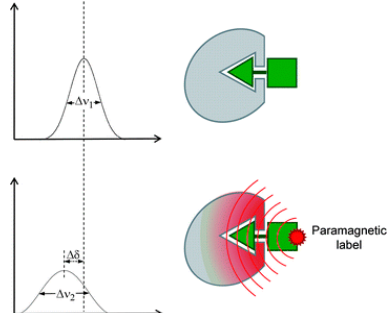
Figure 10. Paramagnetically tagged ligands affect the relaxation properties of their binding partners causing two major effects: pseudo-contact shifts ( Δδ ) and line-broadening ( Δν 2 > Δν 1 ). These effects can be useful for mapping the binding site of the ligand. Adapted with permission of RSC Nat. Prod. Rep. from Application of NMR methods to the study of the interaction of natural products with biomolecular receptors. Calle L.P., Cañada F.J., Jiménez-Barbero J. 28, 6, 2011; permission conveyed through Copyright Clearance Center, Inc. [52].